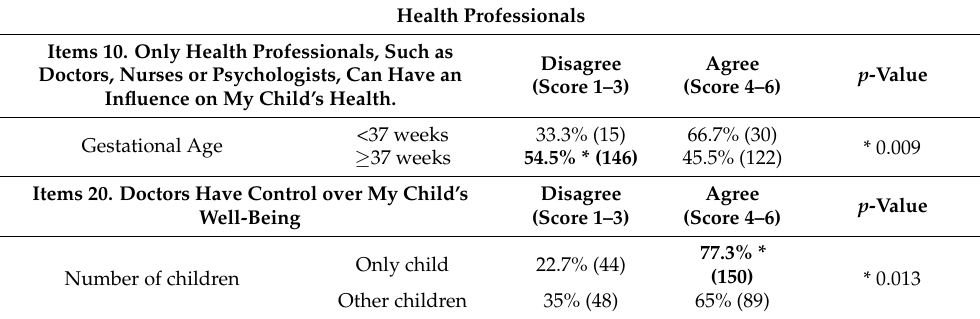
Table 3. Statistically significant correlations between “Health Professionals” category and socio- demographic